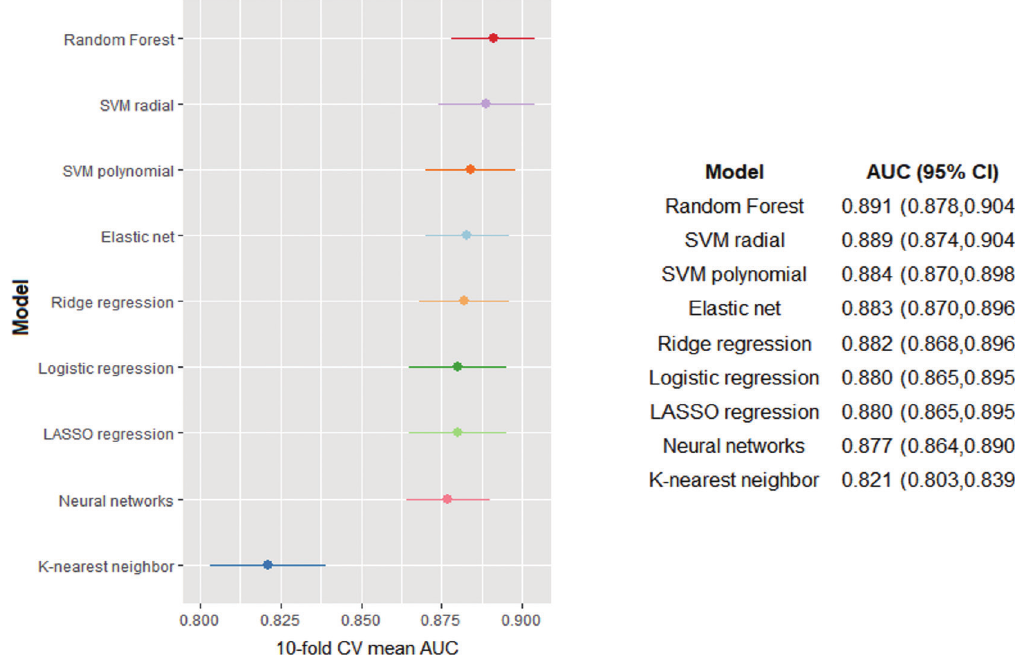
Figure 2. Cross-validated performance of the machine learning algorithms according to the area under the curve (AUC). CV, cross-valida- tion; CI, confidence